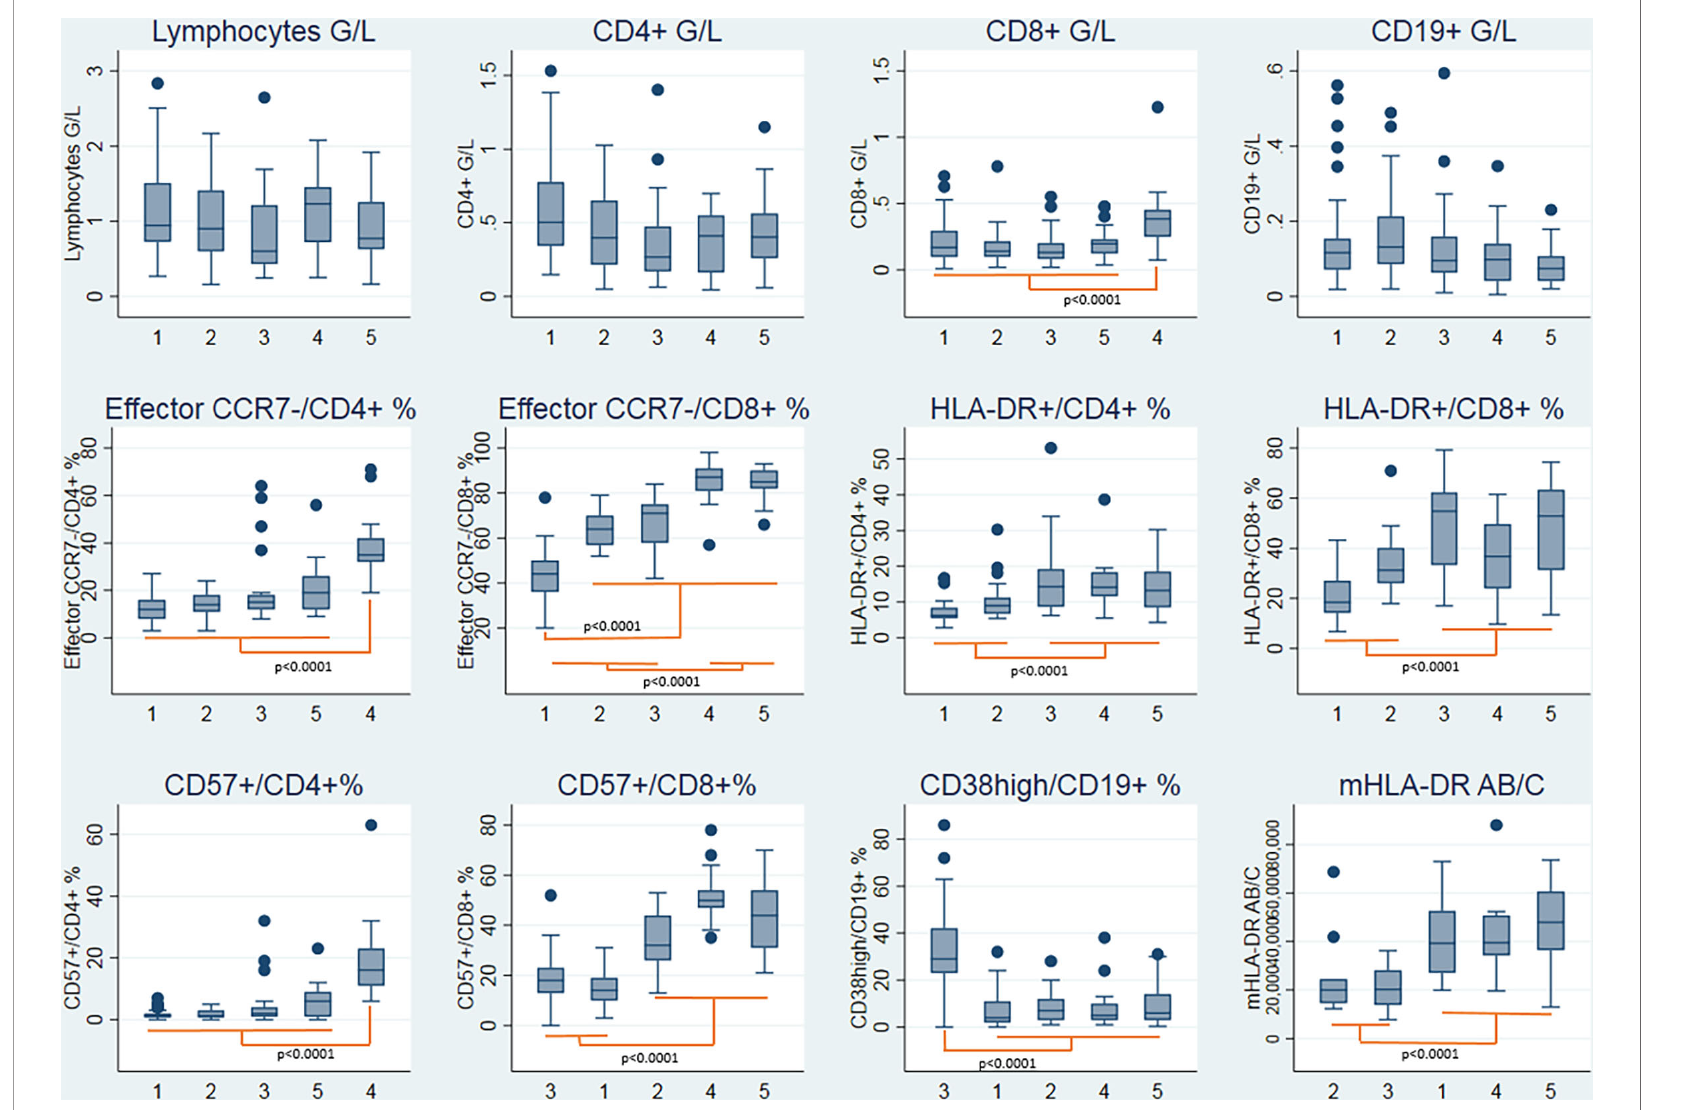
FIGURE 2 | Boxplots representing the immunophenotypic characteristics of the fi ve clusters of patients. Statistical analysis by hierarchical ascendant clustering discriminates the 125 patients with COVID-19 of the cohort in fi ve distinct clusters according to the immunophenotypic variables (Supplementary Methods). Age was included in the model. Boxplots represent the median and the 25 th to 75 th percentiles, the whiskersrepresent the 10 th and the 90 th percentiles; outside values are represented by